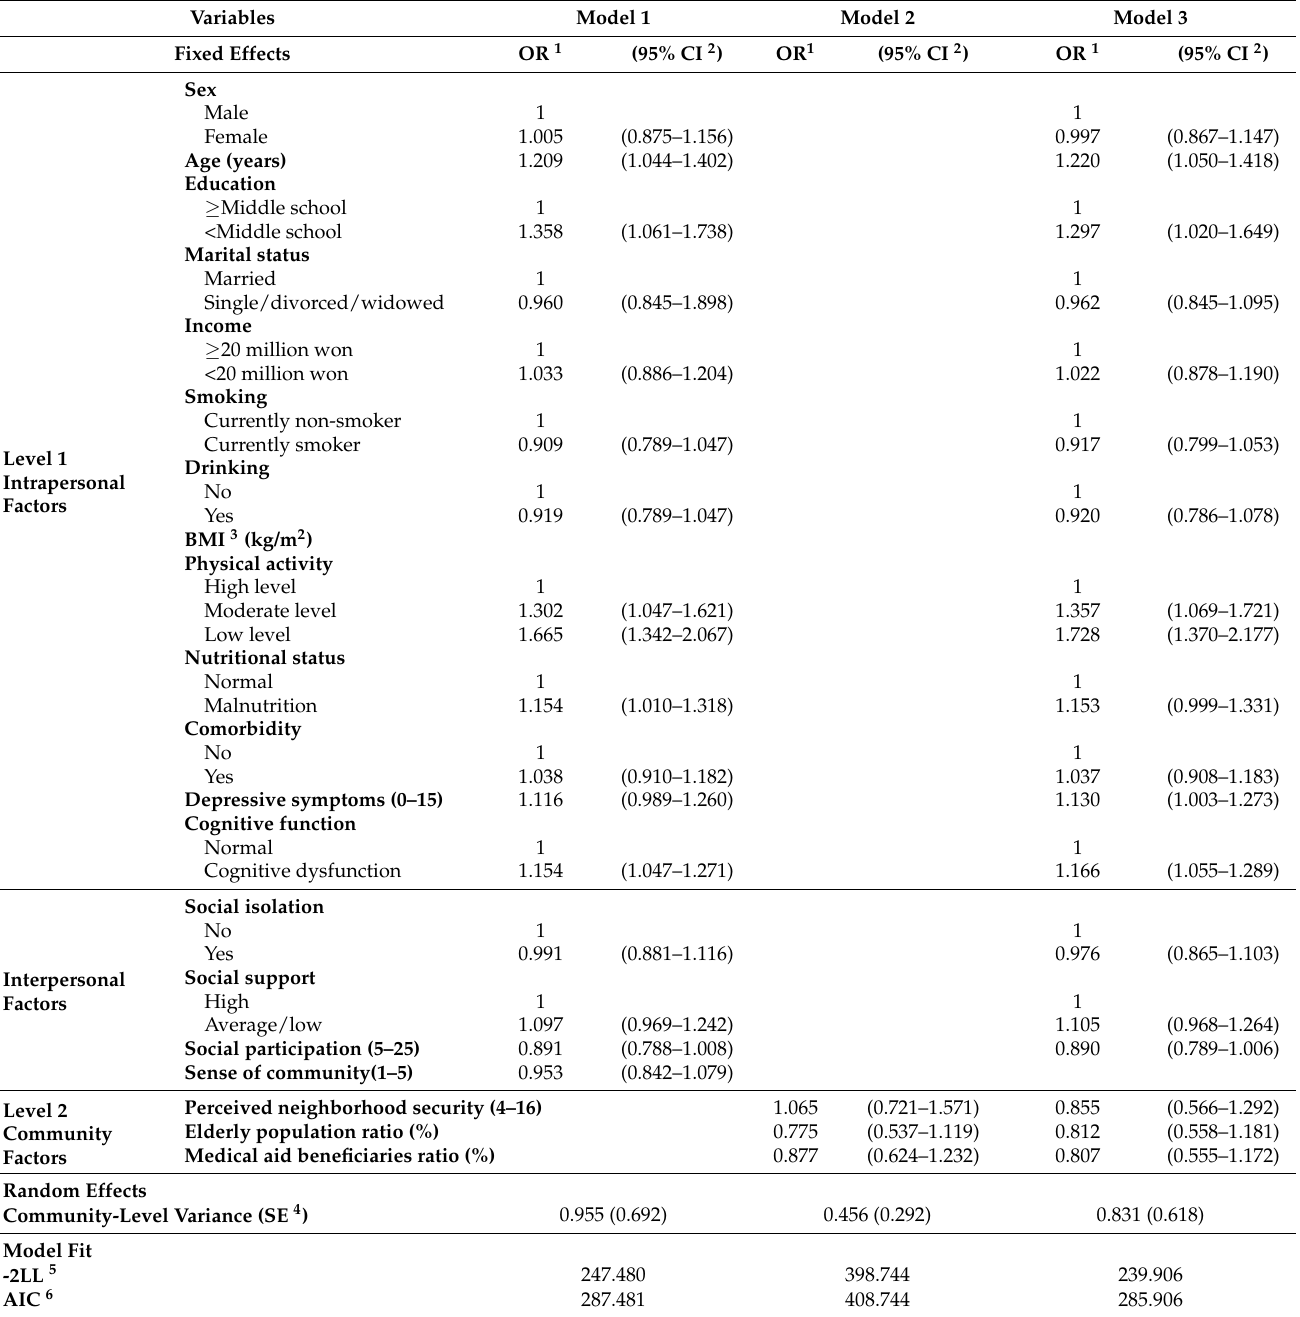
Table 2. Factors associated with frailty among the rural elderly using multilevel logistic regression ( n =